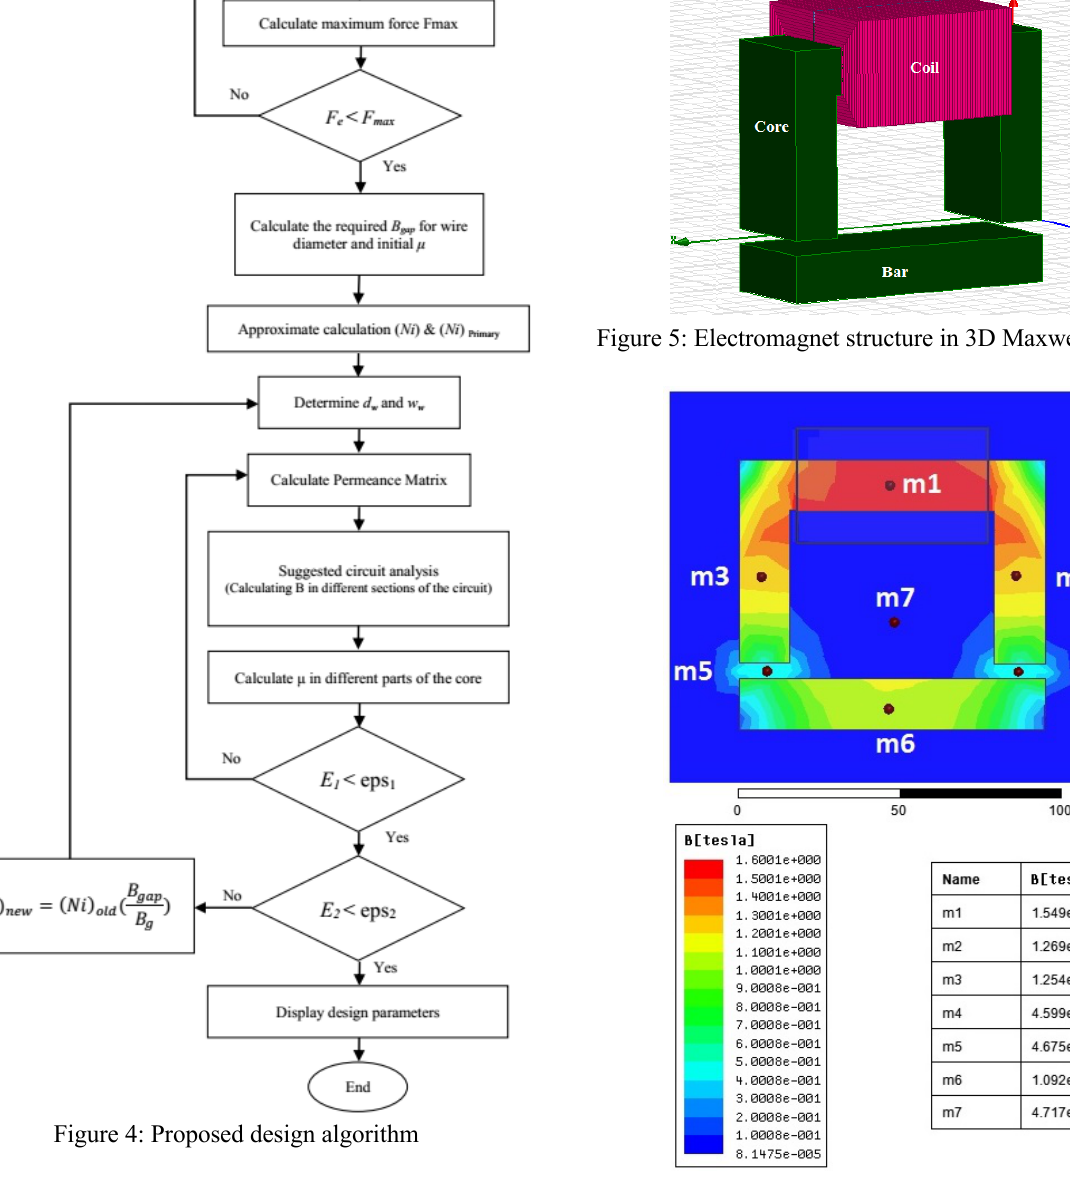
Figure 6: Magnetic field in the